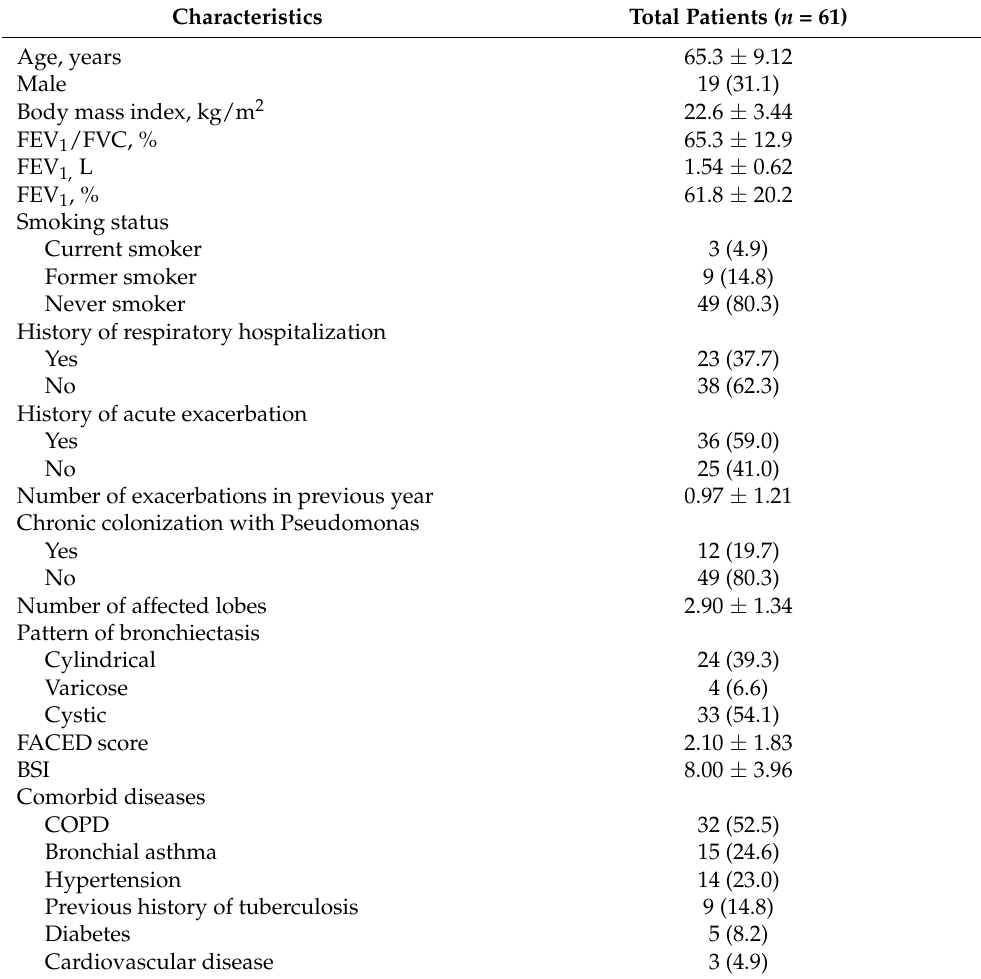
Table 1. Baseline characteristics of study